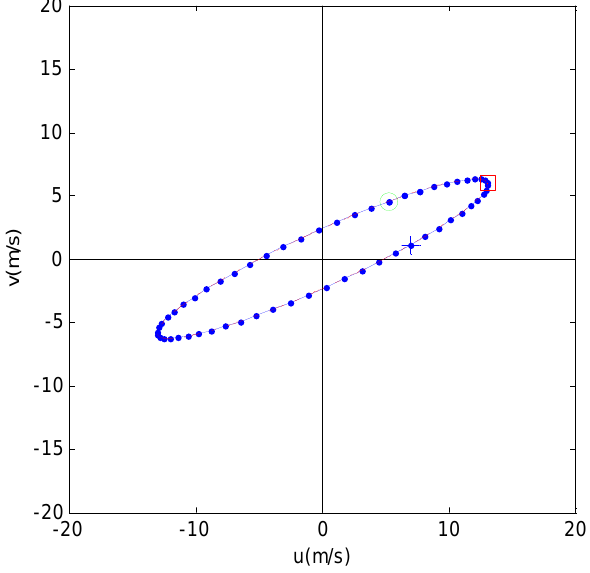
Fig. 2b. Same as Fig. 2a except at the 35th time step. The rotation sense of this hodograph is clockwise (from a green circle to a red square to a blue cross). τ = 3 . 17h and φ az = 65 . 4 ◦ were obtained by this analysis.